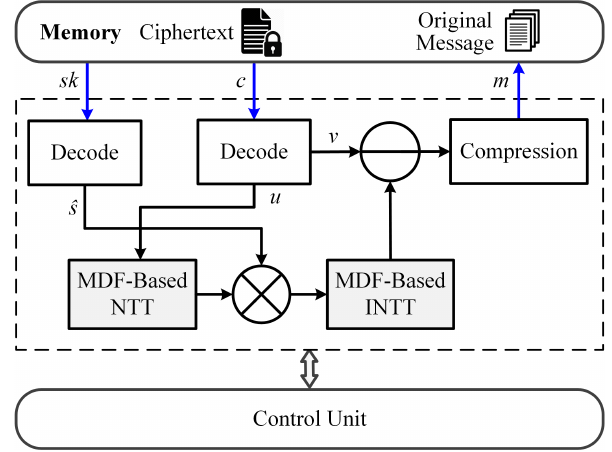
Figure 7. Proposed decryption architecture.